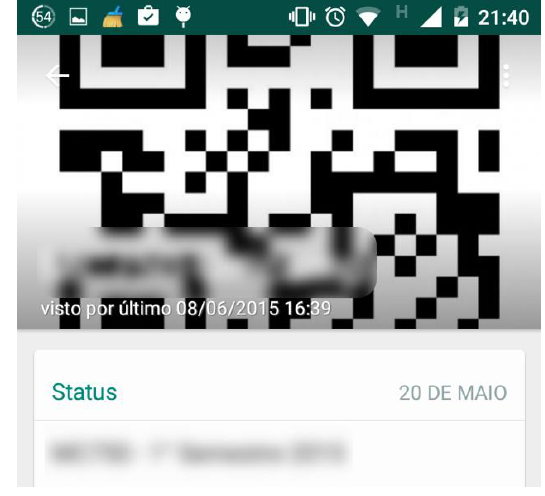
Fig 5. System’s contact added to the contact